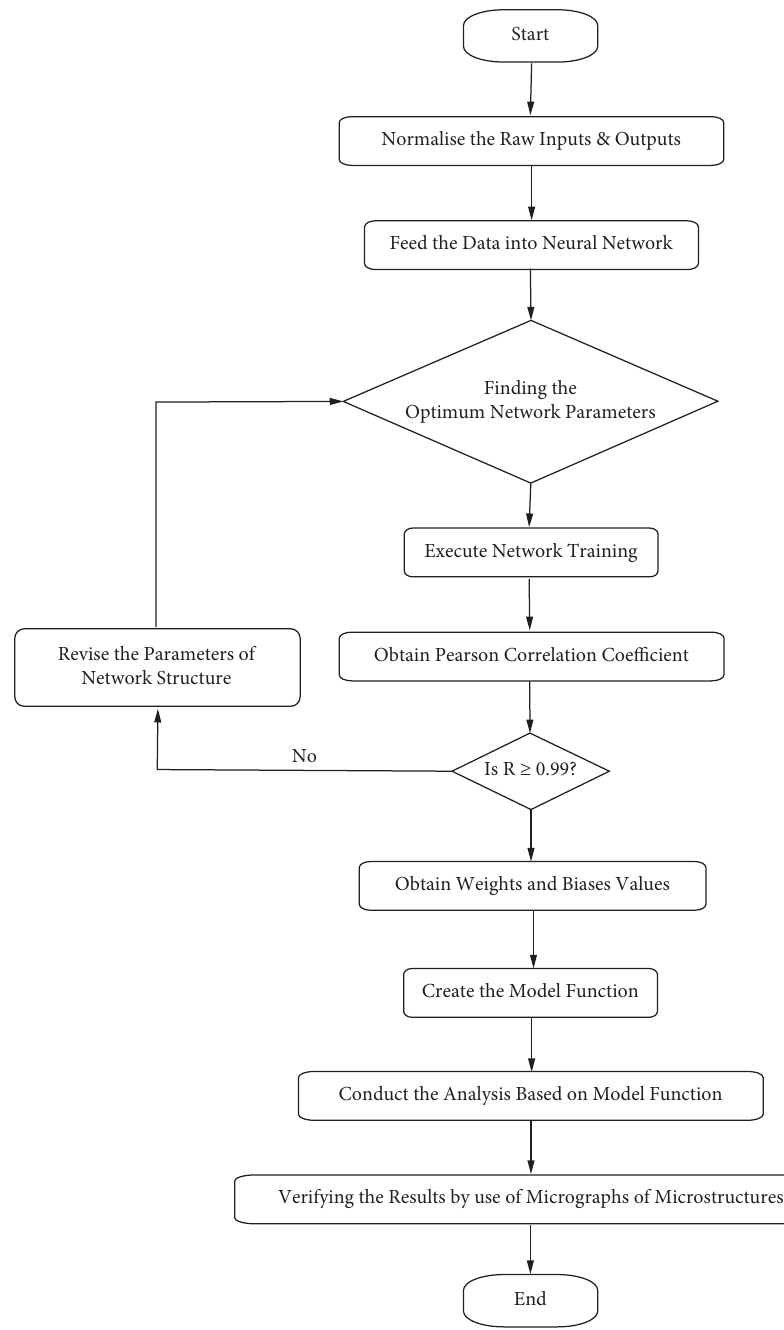
Figure 2: Network training, exploration of ANN training results, and evaluation of result composition of the technique. Table 2: Assembly and the factors of